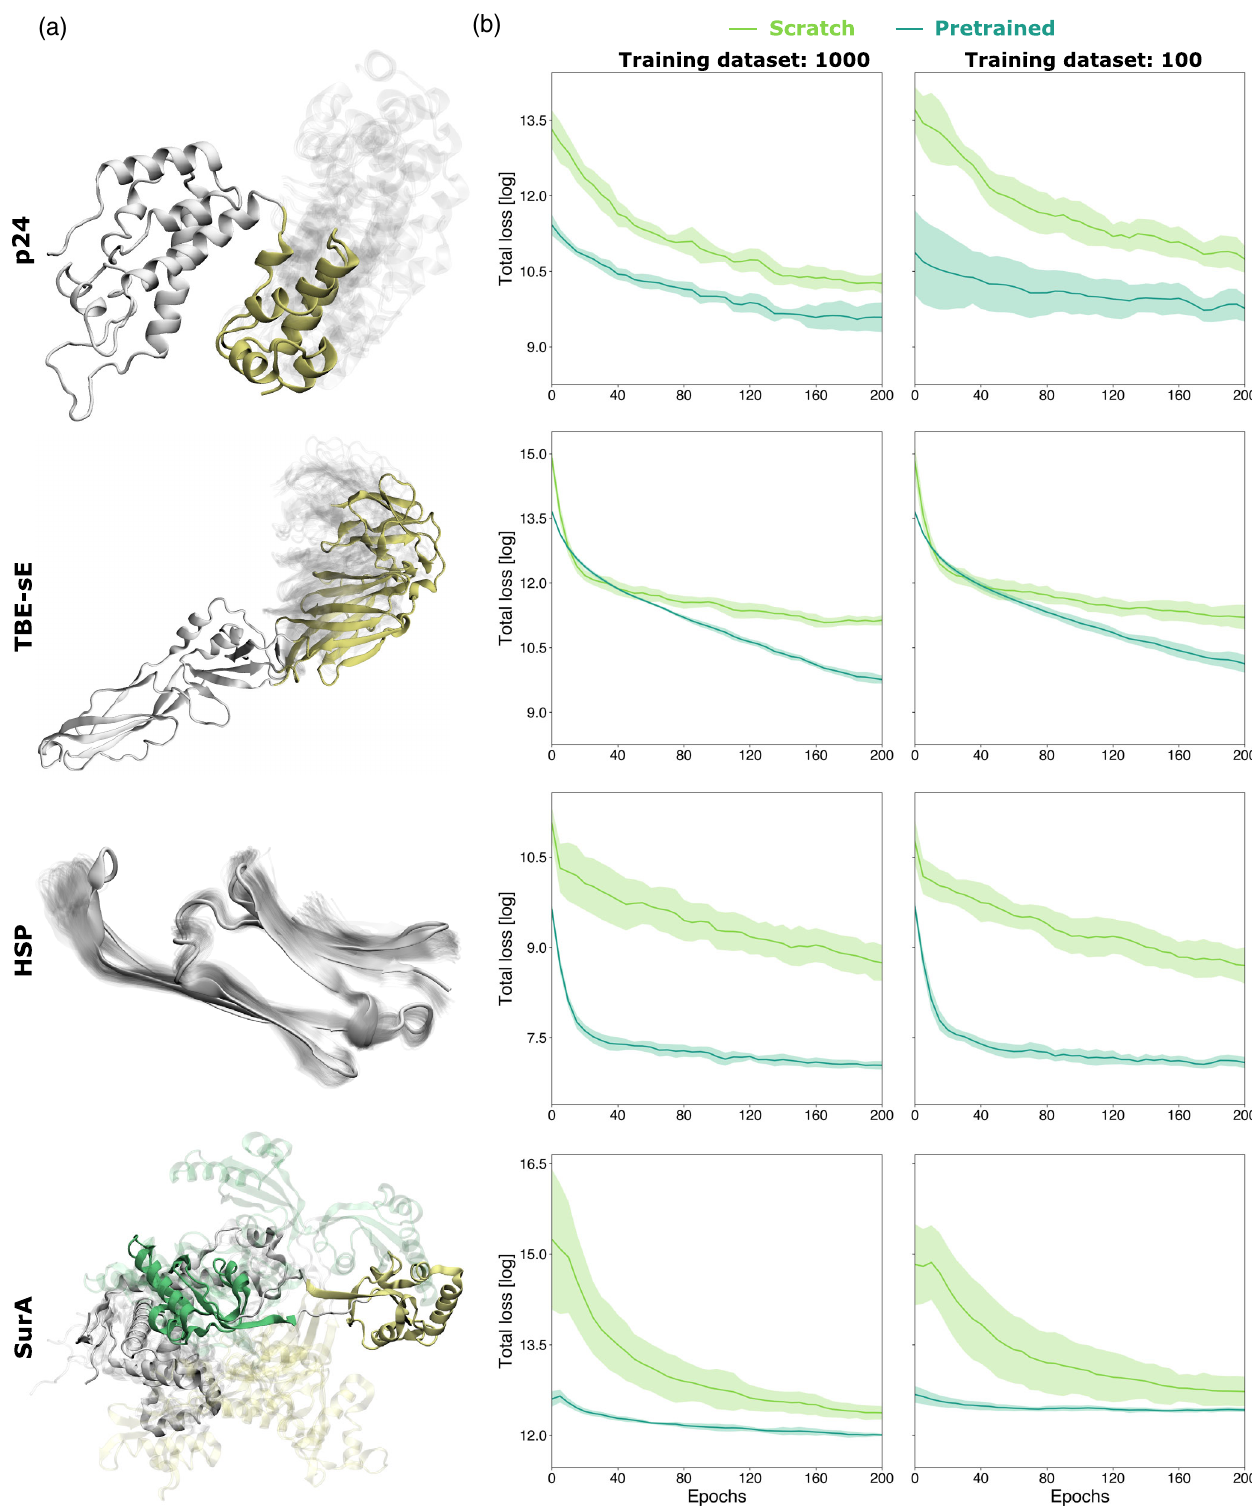
FIG. 5. Transfer learning of our best network trained on MurD to four different proteins. (a) Side view of p24, TBE-sE, HSP, and SurA showing example alternative conformations with transparency and the highly mobile domains of p24, TBE-sE, and SurA in color (yellow and green). (b) Moving average (window of 3) mean (solid line) and standard deviation (shaded region) of the total loss (log scale) comparing the performance of the pretrained network with its counterpart trained from scratch using a training dataset of size 1000 and 100, all using the same loss function featuring both MSE and physics-based